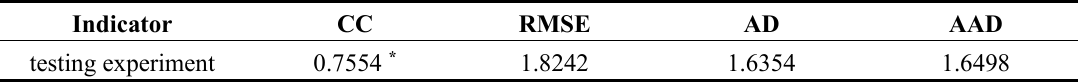
Figure 9. Scatter plots between the predicted and original LSTs at 60 m of the testing experiment on 7 December 2013. x -axis denotes the original LSTs, and y -axis denotes the prediction LSTs. Table 2. Indicators of prediction accuracy on 7 December 2013 (unit: